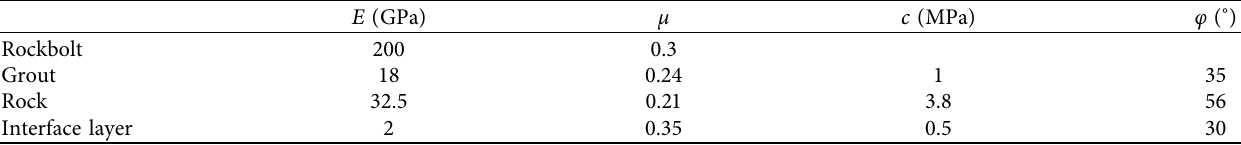
Table 5: Mechanical parameters of the materials.